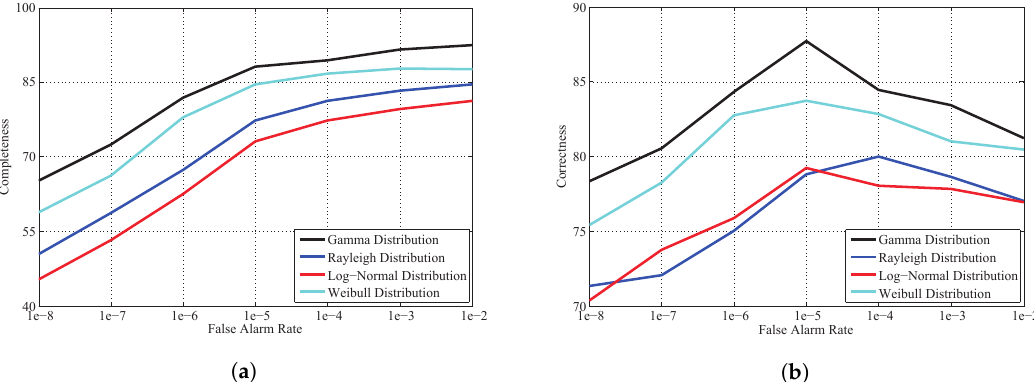
Figure 6. Character curves of the performance of the different statistical distributions at different false alarm rate thresholds. ( a ) completeness; and ( b )